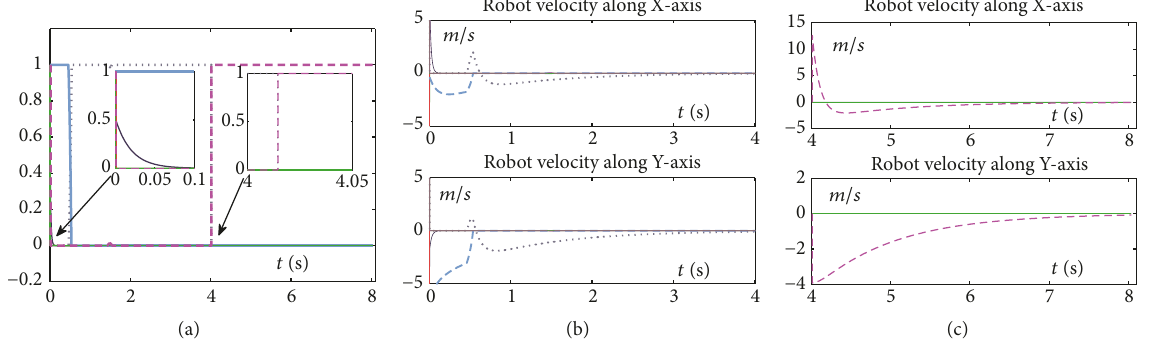
Figure 9: Outputs of 𝑘 -WTA network in distributed coordination model (19) with 𝑘 = 1 as well as the corresponding velocities of mobile robots at different phases. (a) Outputs of 𝑘 -WTA network with 𝑘 = 2 . (b) Velocities of mobile robots of phase 1. (c) Velocities of mobile robots of phase